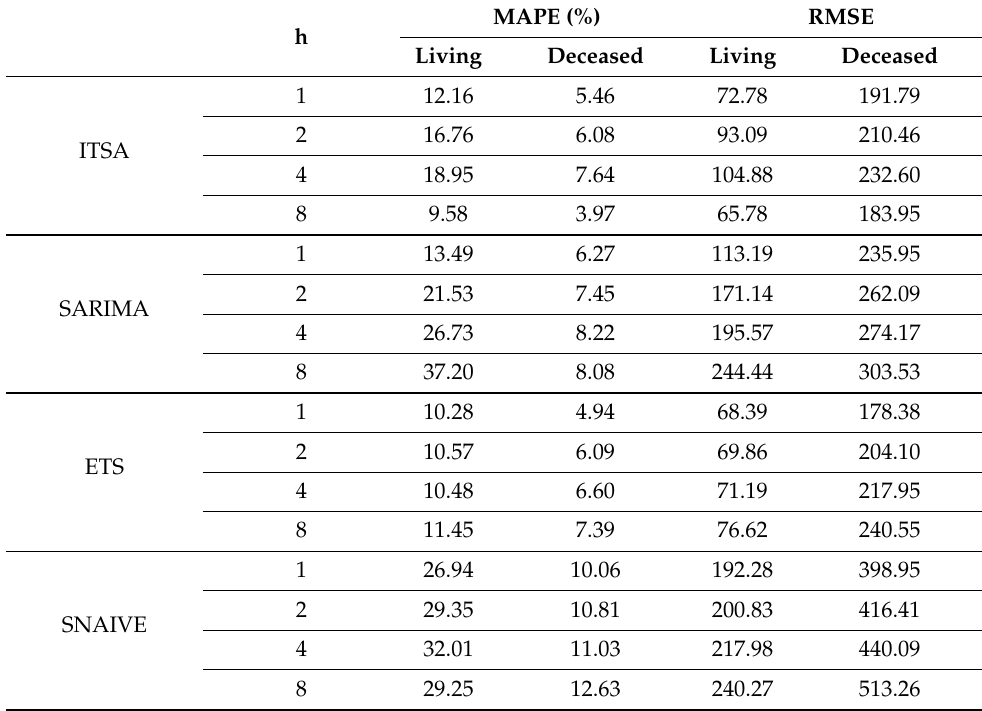
Table 1. Forecast accuracy measures by donor type at various forecast